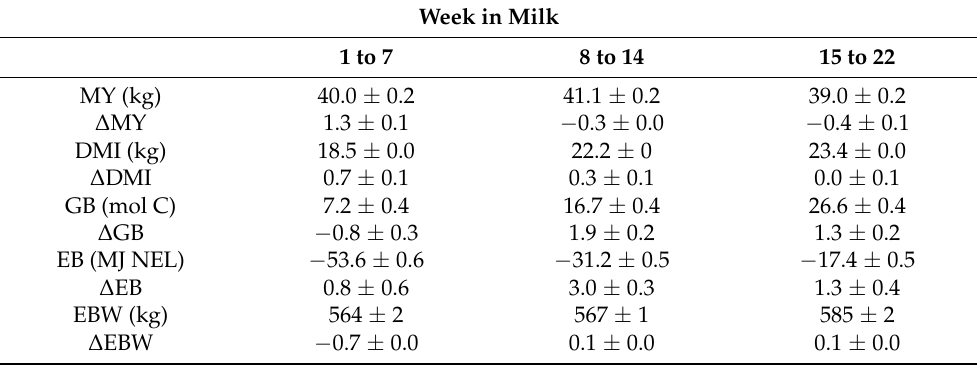
Table 1. Means of milk yield (MY, kg/d), dry matter intake (DMI, kg/d), glucose balance (GB, mol C/d), energy balance (EB; MJ of net energy for lactation (NEL)), and empty body weight (EBW, kg) as well as means of the weekly change ( ∆ ) in average daily MY, DMI, GB, EB, and EBW during different stages of early lactation (data of all cows and lactations enrolled in the study). Week in